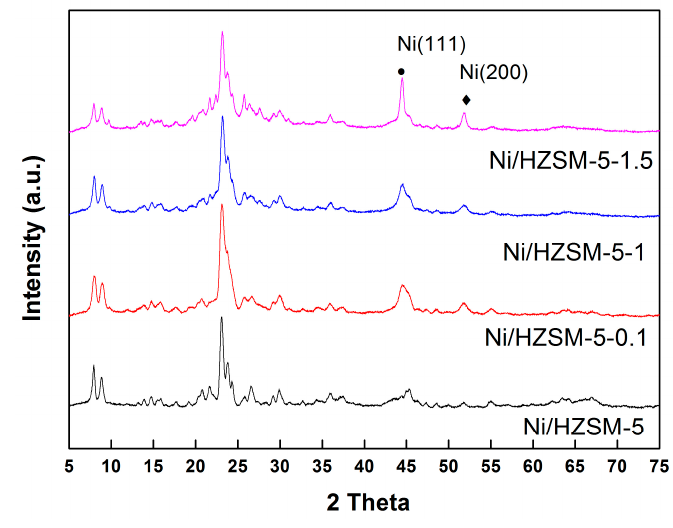
Figure 4. XRD patterns for reduced Ni catalysts supported over parent HZSM ‐ 5 and the hierarchical HZSM ‐ 5.